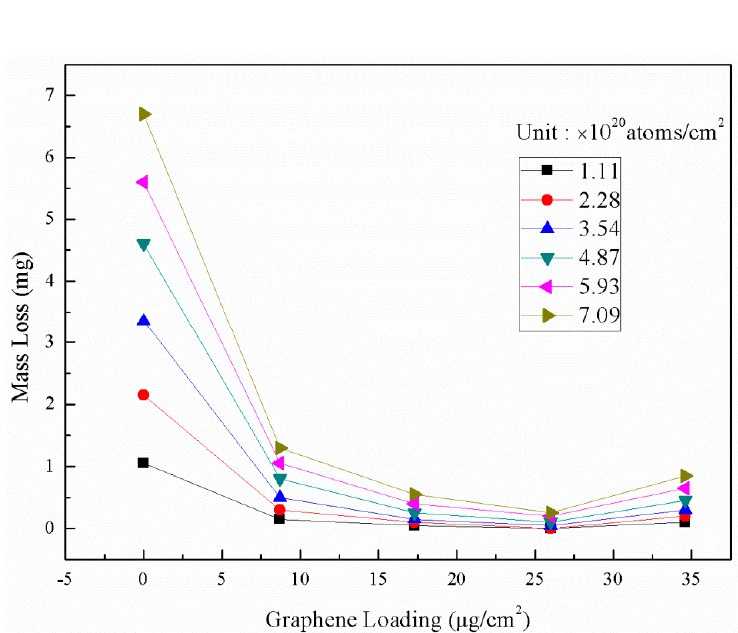
Figure 7. Mass loss of coated Kapton with different graphene loadings in the AO exposure experiment.